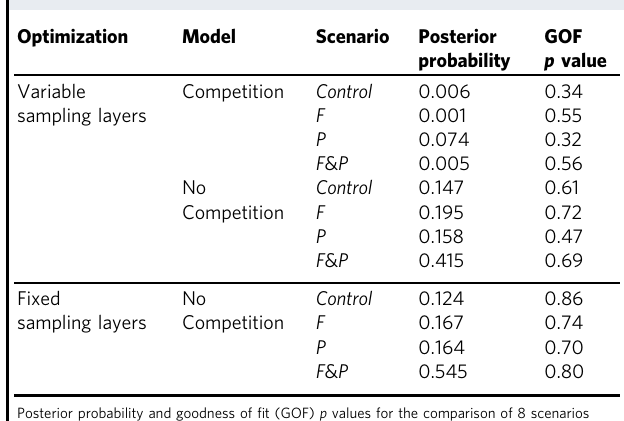
Posterior probability and goodness of fi t (GOF) p values for the comparison of 8 scenarios ( “ Control ” , “ F ” , “ P ” , and “ F & P ” with and without direct competition), without sampling layer optimization, and for the comparison of the 4 scenarios without competition ( “ Control ” , “ F ” , “ P ” , and “ F & P ” ), with sampling layer